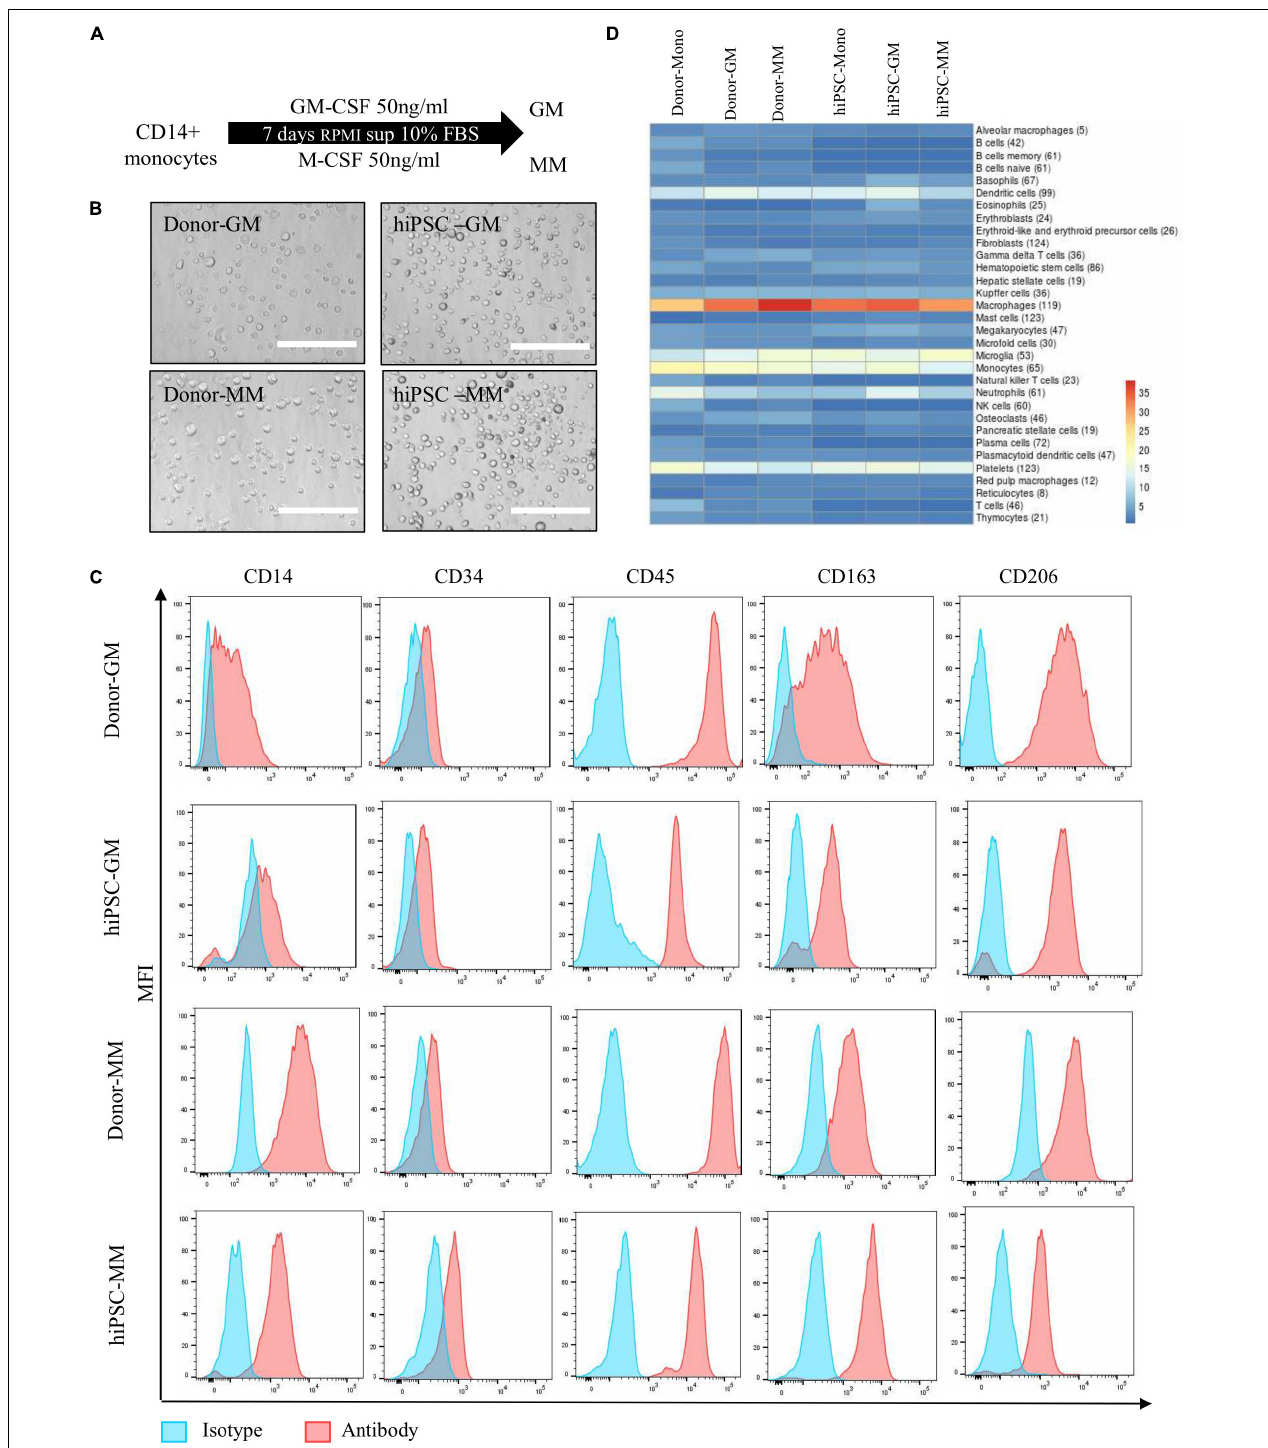
FIGURE 2 | Differentiation and characterization of human induced pluripotent stem cell (hiPSC)-derived monocytes to macrophages. (A) Differentiation overview of GM and MM macrophages from hiPSC-derived or donor-derived CD14 + monocytes. (B) Representative images of cell morphology from GM and MM macrophages in donor and hiPSC groups. Scale bar represents 200 µ m. (C) Macrophage marker expression level between hiPSC-derived macrophages and donor-derived macrophages. (D) Heatmap presents cell type marker analysis of donor- and iPSC-derived monocyte, and GM and MM macrophages differentiated from relative monocytes. Color scale reflects log10 ( p -value) of Wilcoxon rank sum test comparing expression levels of cell type marker genes for each cell type against all other cell types. Numbers in parentheses refer to the number or marker genes for the respective cell type.